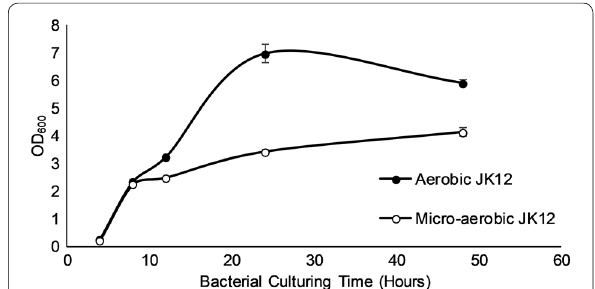
Fig. 4 Effects of the oxygen on the growth of JK12. All error bars indicate the SD of the three biological replicates